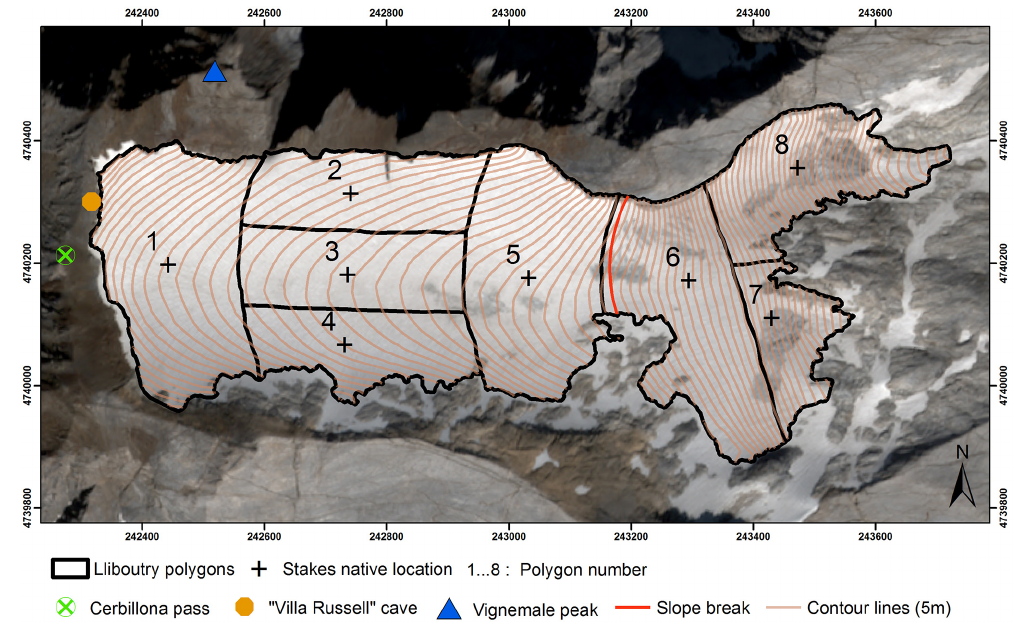
Figure 3. Distribution of stakes at Ossoue Glacier. CNES © image Pléiades MS-09-23-2013. UTM 31 ◦ N projection.